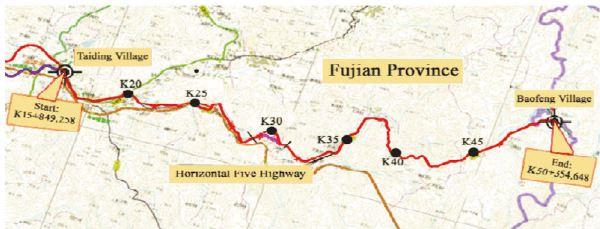
Figure 3: Map of Horizontal Five highway used for evaluation. (Source: Fujian Police Department, China) Table 3: Panel data of 13 indices related to selected crashes on the expressway and intersections (total number of crashes is 117) a . Crash